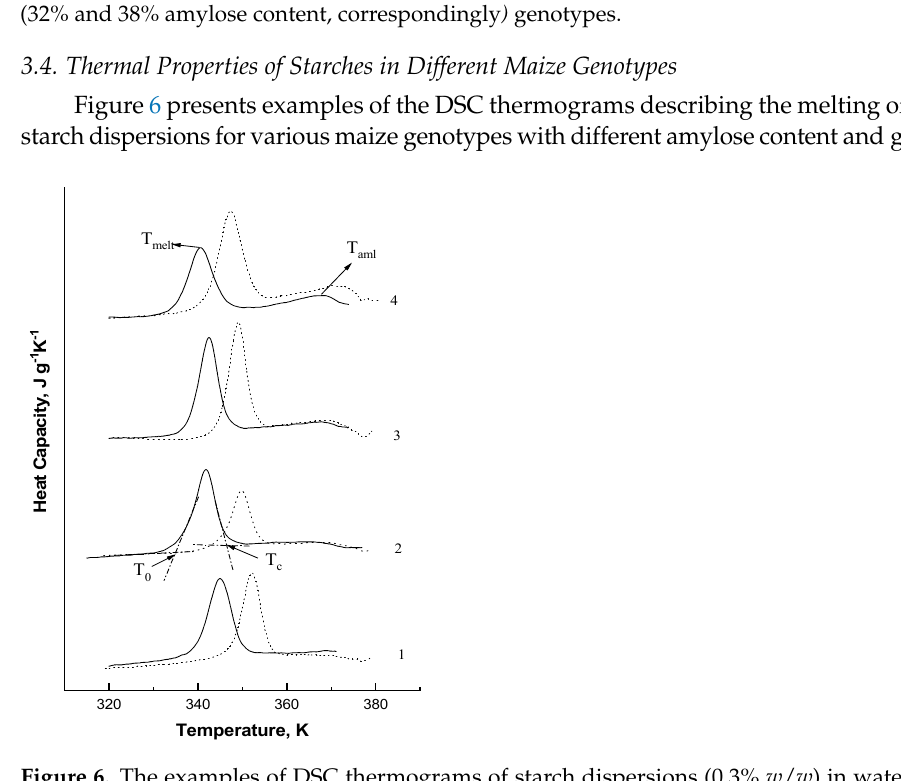
Figure 6. The examples of DSC thermograms of starch dispersions (0.3% w / w ) in water (straight line) and in 1.6 M KCl (dotted line) with different genotypes and amylose content: 1— wx (0% amylose content), 2—wt (15% amylose content), 3—“ ae ” (38.0% amylose content), 4— su (25.5% amylose content) genotypes. T m is the melting temperature for amylopectin crystalline lamellae; T 0 and T c − onset and conclusion temperatures of amylopectin crystalline lamellae melting; T aml is the melting temperature of the amylose–lipid complex.